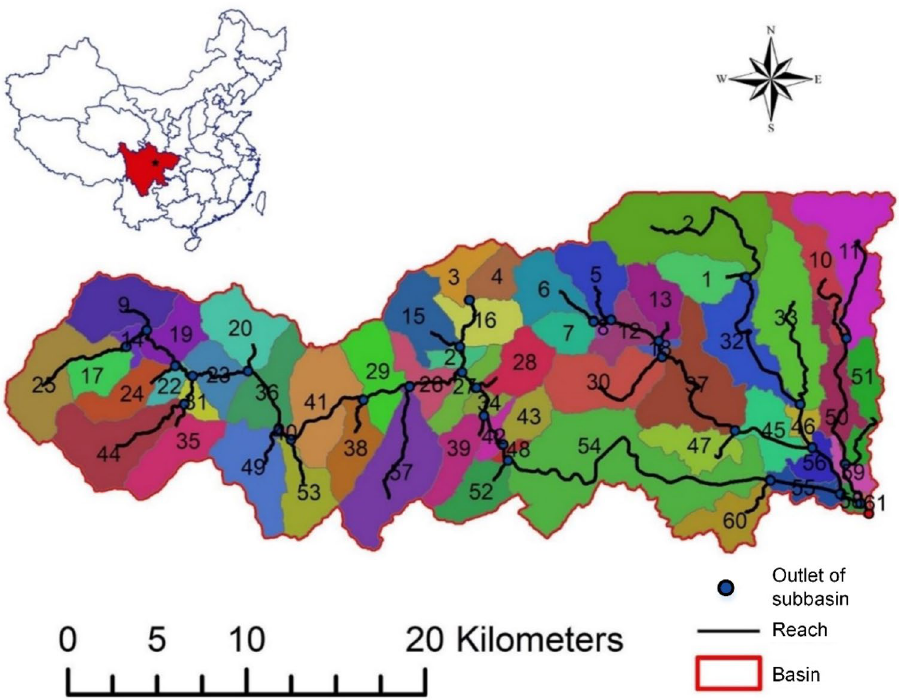
Figure 2. Location map of the upstream of the Wenjing River watershed 12. The map is generated with ArcMap Version 10.5.